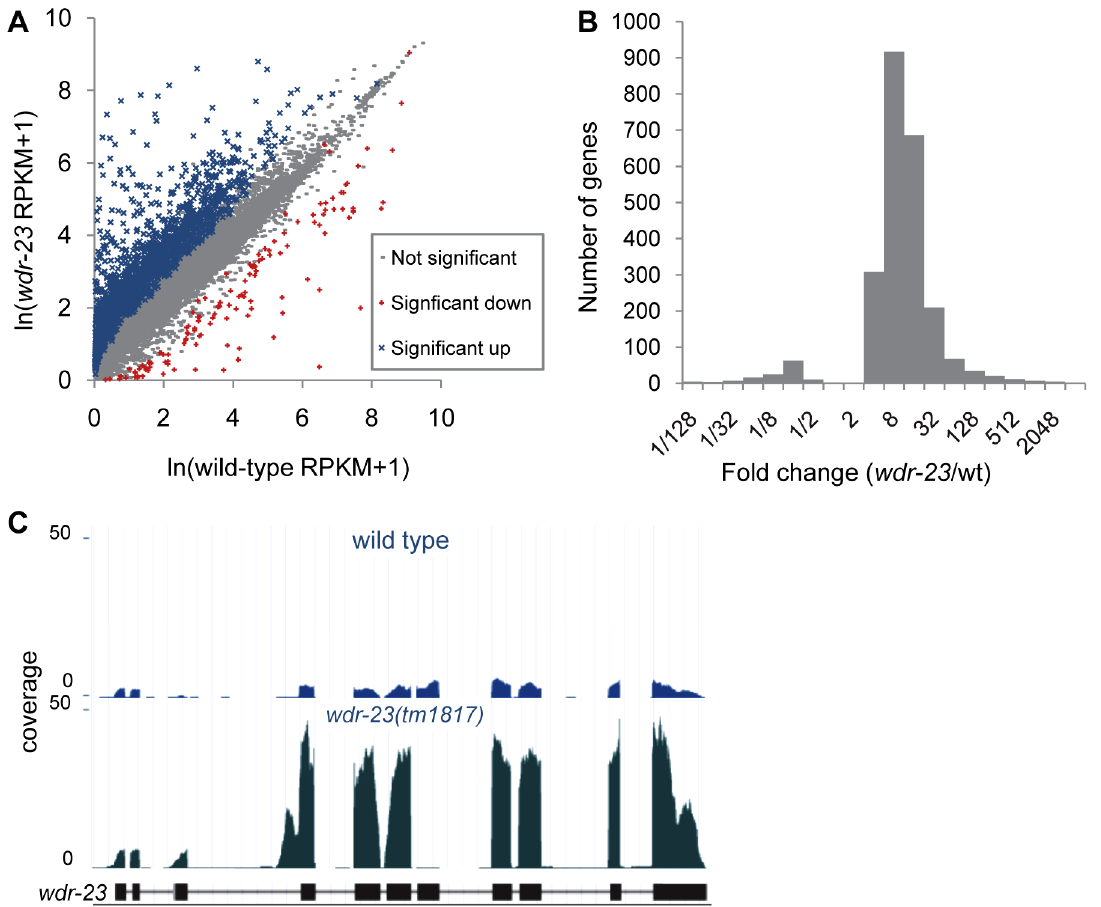
Figure 7. Analysis of whole-transcriptome RNA sequencing of wdr-23 mutants. (A) Correlation plot of RNA-seq reads for wild type versus wdr-23 mutants. Genes significantly different are indicated in blue (up-regulated) and red (down-regulated). (B) Distribution of fold change of genes significantly different in wdr-23 mutants relative to wild type controls. (C) Coverage plot of RNA-seq reads of wdr-23 in wild type and wdr-23(tm1817) mutants.